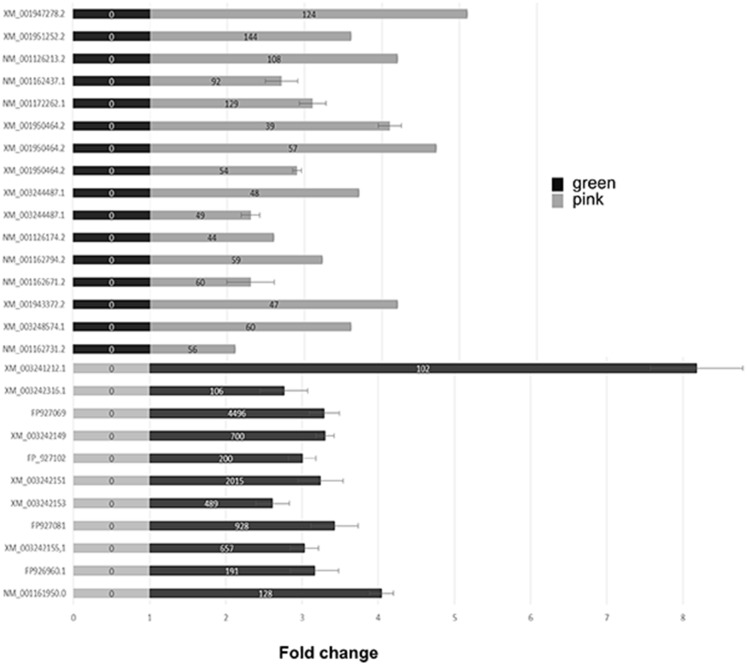
Quantitative PCR analysis of selected genes to assess the pyrosequencing transcriptomic data.Bars represent fold expression of gene of interest in the orange aphids (black) and the green-cold-adapted ones (grey). For each gene of interest, the normalized expression was rescaled by minimal sample value. The accumulation of each transcript was measured in three independent biological samples for each aphid variant. Statistically significant differences were determined by Student’s test analyses. The numbers in the bars are the reads obtained by RNA enrichment (SSH) followed by pyrosequencing of the corresponding cDNA.